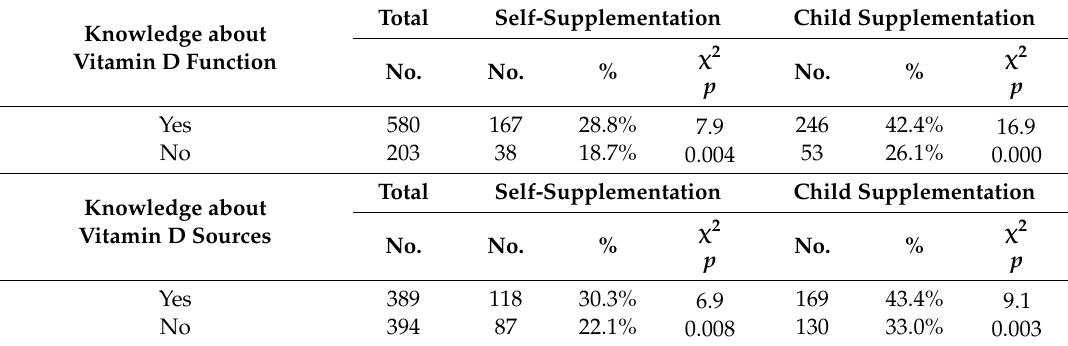
Table 3. Popularity of self- and child supplementation among parents who are and are not aware of vitamin D dietary sources and functions ( n = 783) ( p =